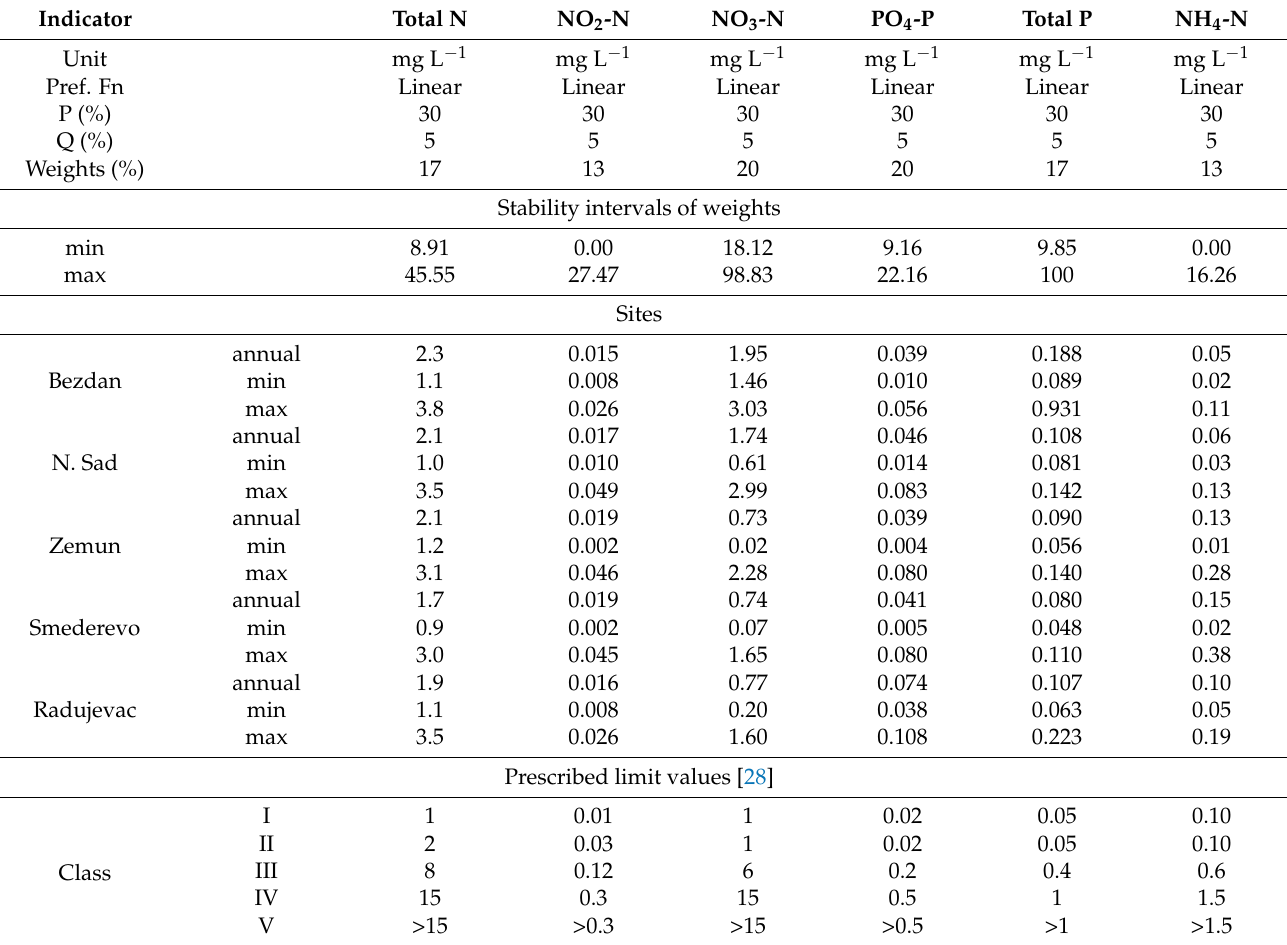
Table 1. Values of nutrient content indicators together with the evaluation scenario.